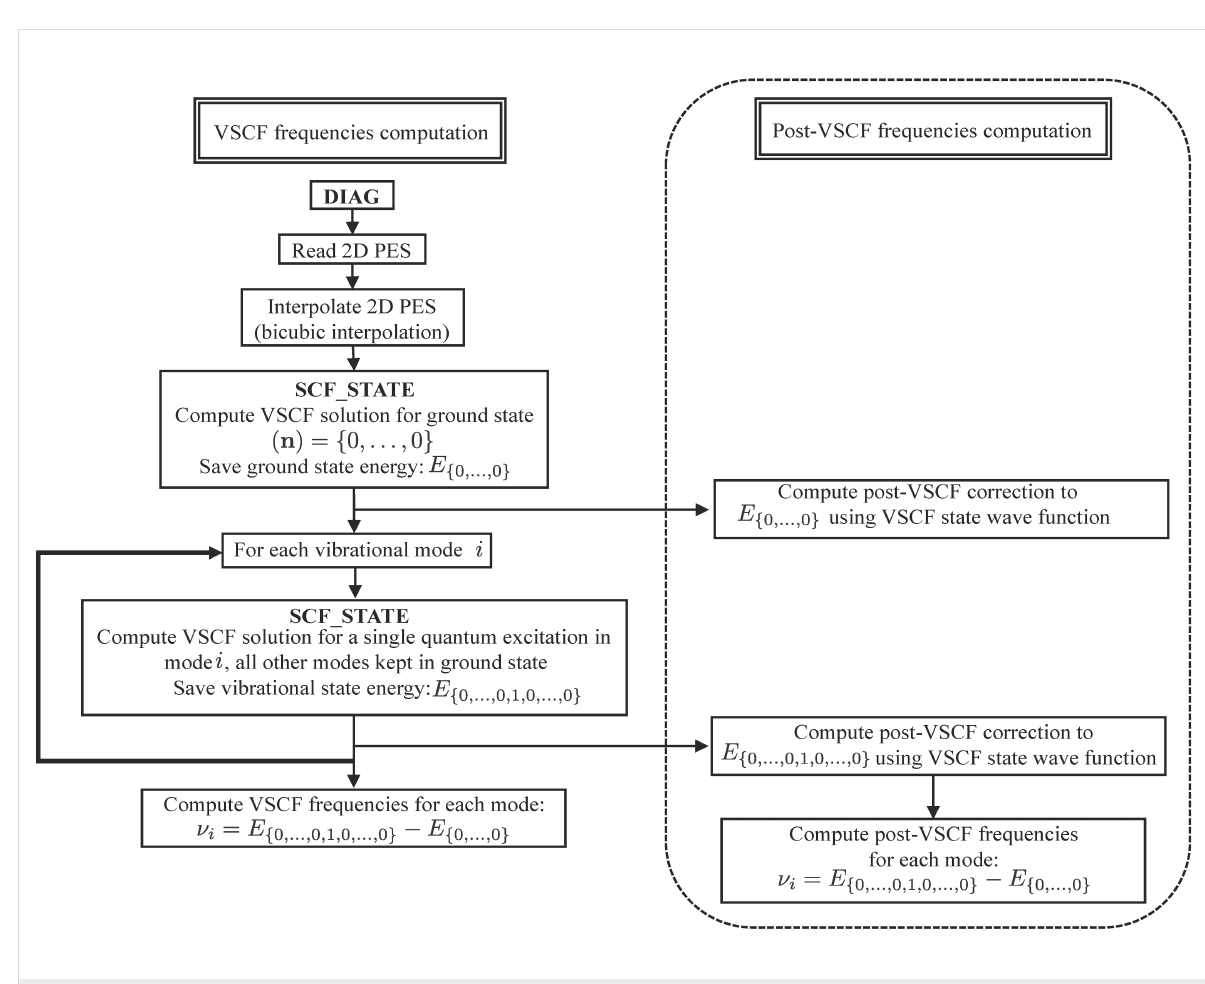
Figure 3: Flow-chart diagram of the computer code used to compute the VSCF and post-VSCF frequencies (dotted part of the